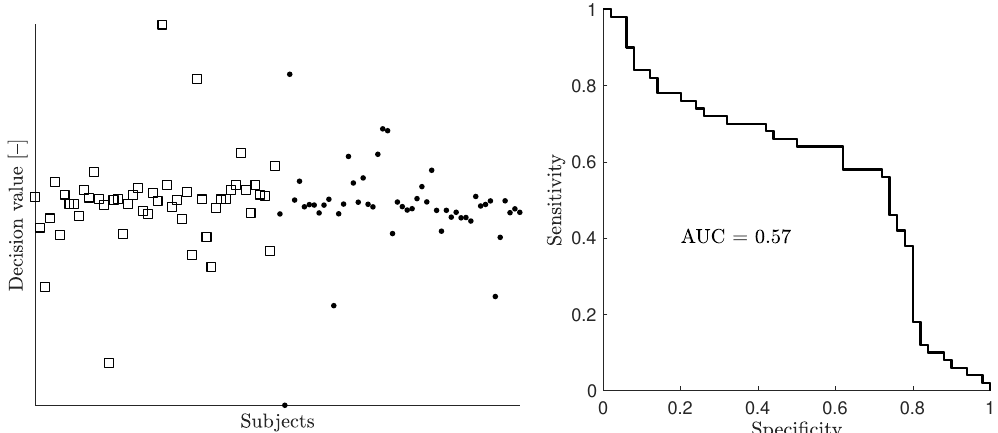
Figure 6. Example of a scatter plot (left) and corresponding ROC/AUC (right) for a random stratified subset containing 100 subjects. In the scatter plot, patient models with bleeding ( n = 50) are shown with squares, whereas healthy subjects ( n = 50) are shown with